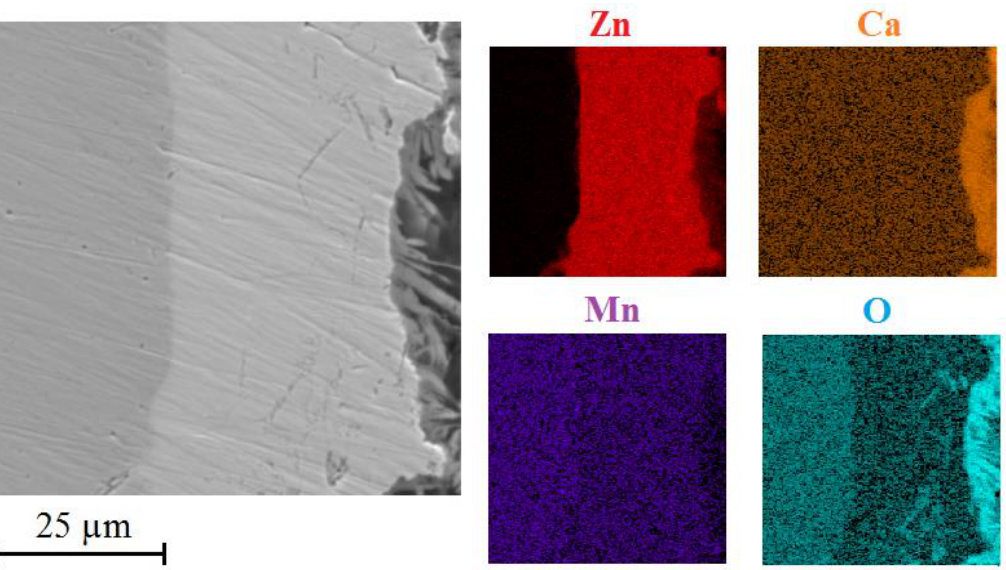
Figure 16. SEM—distribution of Zn/Ca/Mn/O on cross section in precipitate of corrosion products (exposure in simulated concrete pore solution of pH 12.8 without MnO 4 − addition).